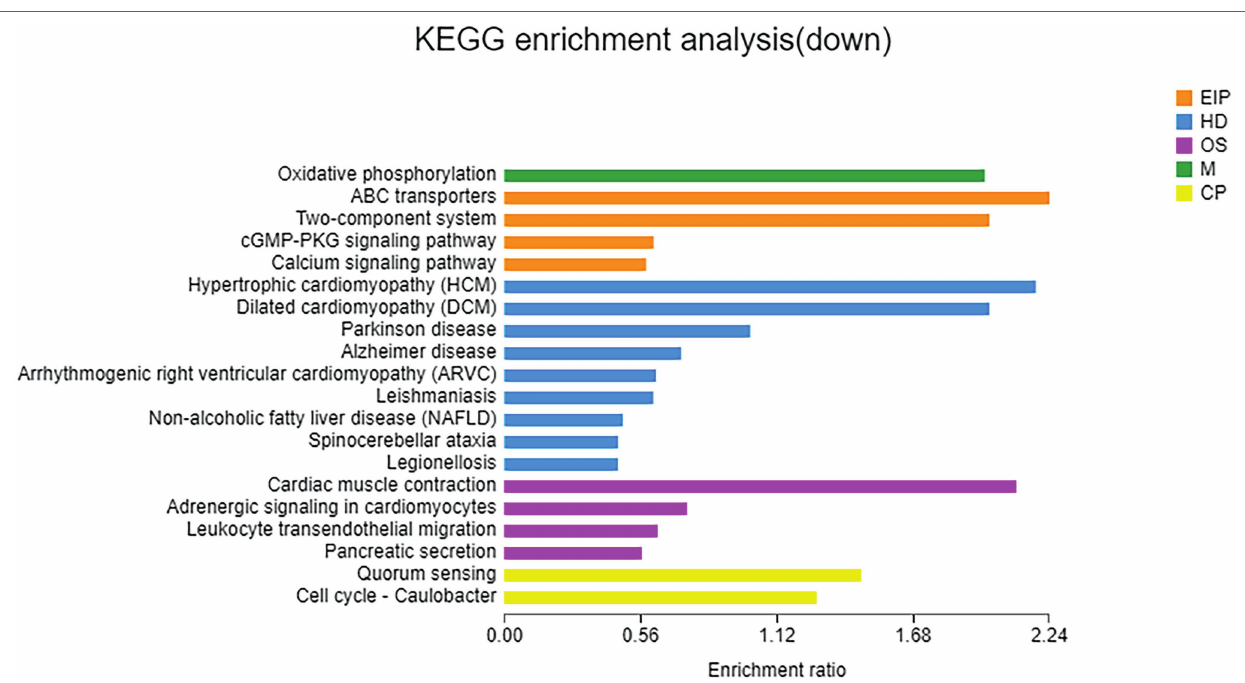
FIGURE 7 | KEGG enrichment analysis of downregulated genes. X-axis, enrichment ratio; Y-axis, functional